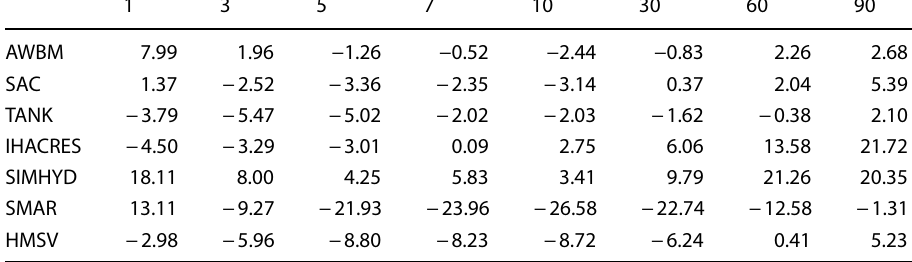
Table 4 Model biases (%) in simulating high-flow quantiles